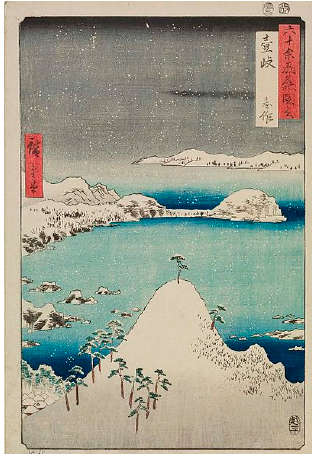
Figure 9. Utagawa Hiroshige (1797–1858), Shisa ,